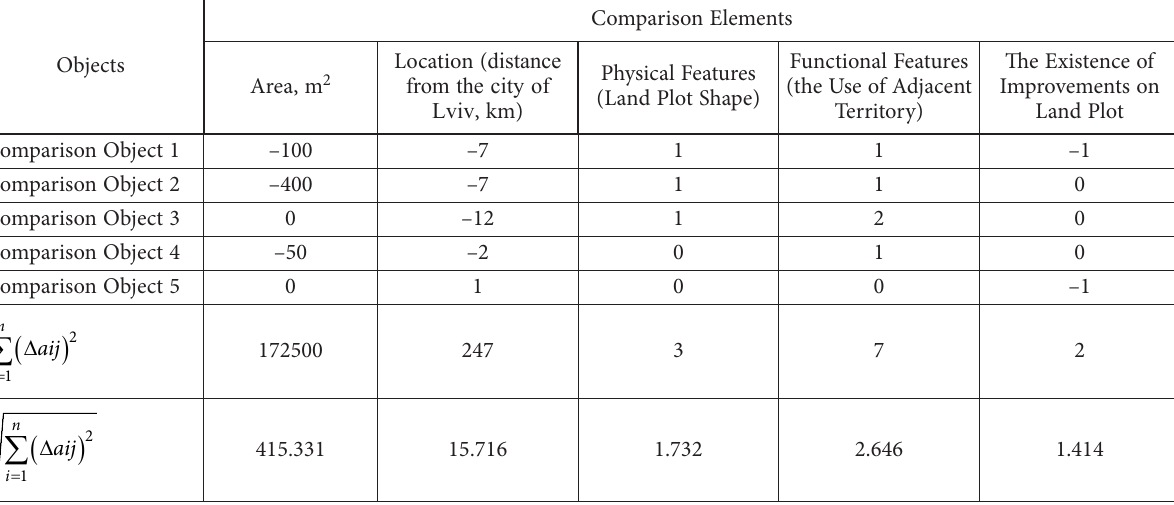
Table 4. Calculation of the base of the valuation of the comparison